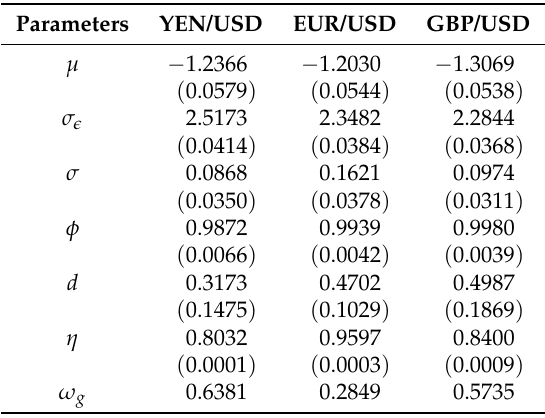
Table 5. Estimates of GLMSV for Daily Currency